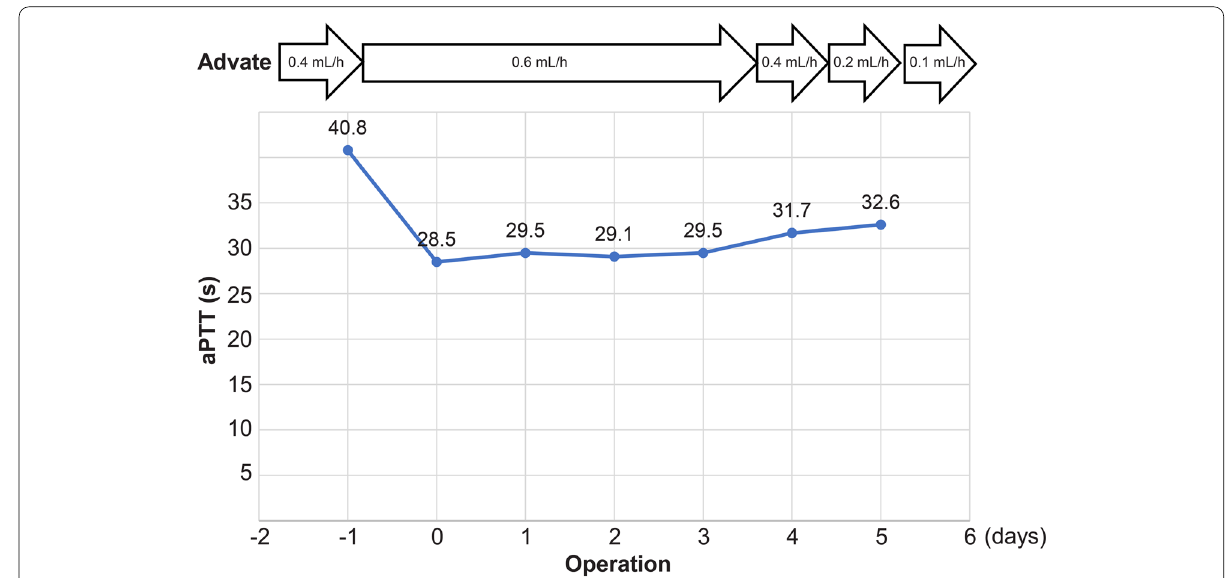
Fig. 2 Changes in activated partial thromboplastin time